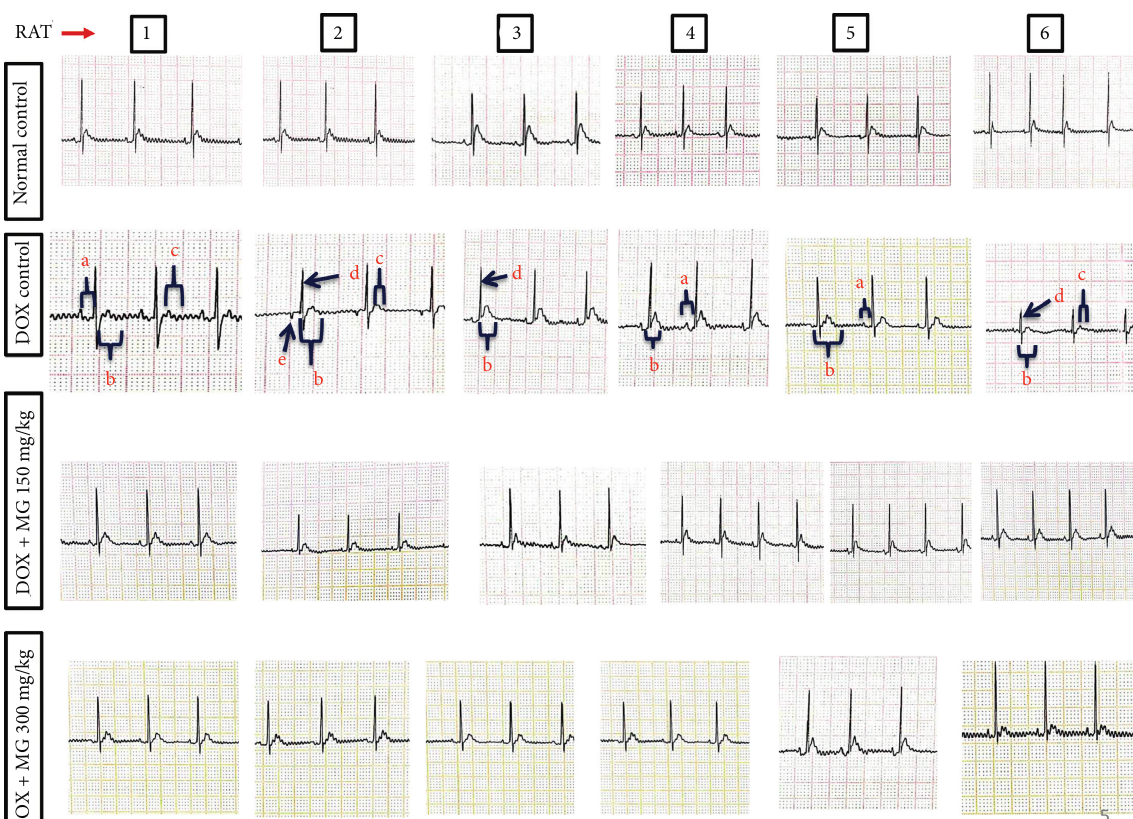
Figure 1: Qualitative analysis of ECG of all the experimental groups: a: increased PR interval, b: prolongation of the QT interval, c: nonspecific ST segment, d: reduced QRS complex amplitude, and e: inverted P